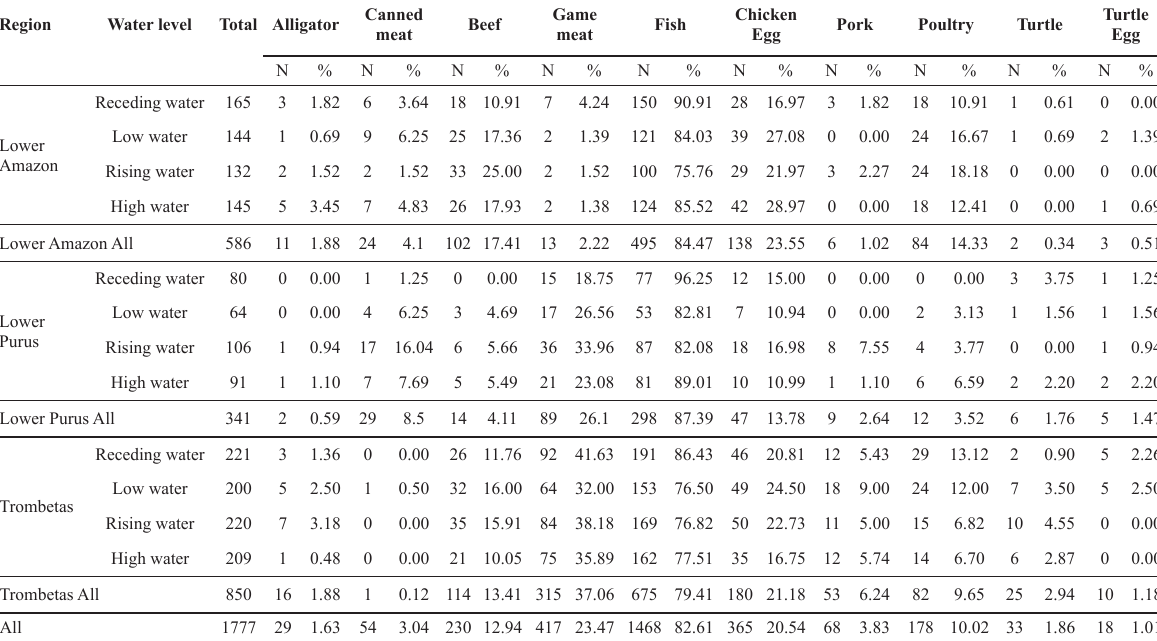
Consumption (number of records and frequency of occurrence) of each food type per period and study area. Region Water